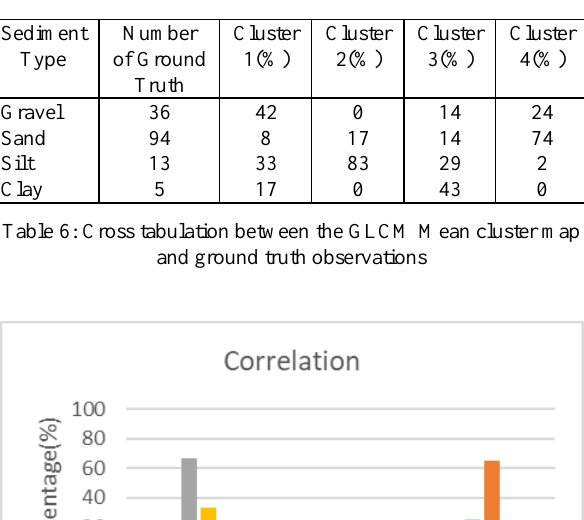
Table 5: Cross tabulation between the GLCM Correlation cluster map and ground truth observations